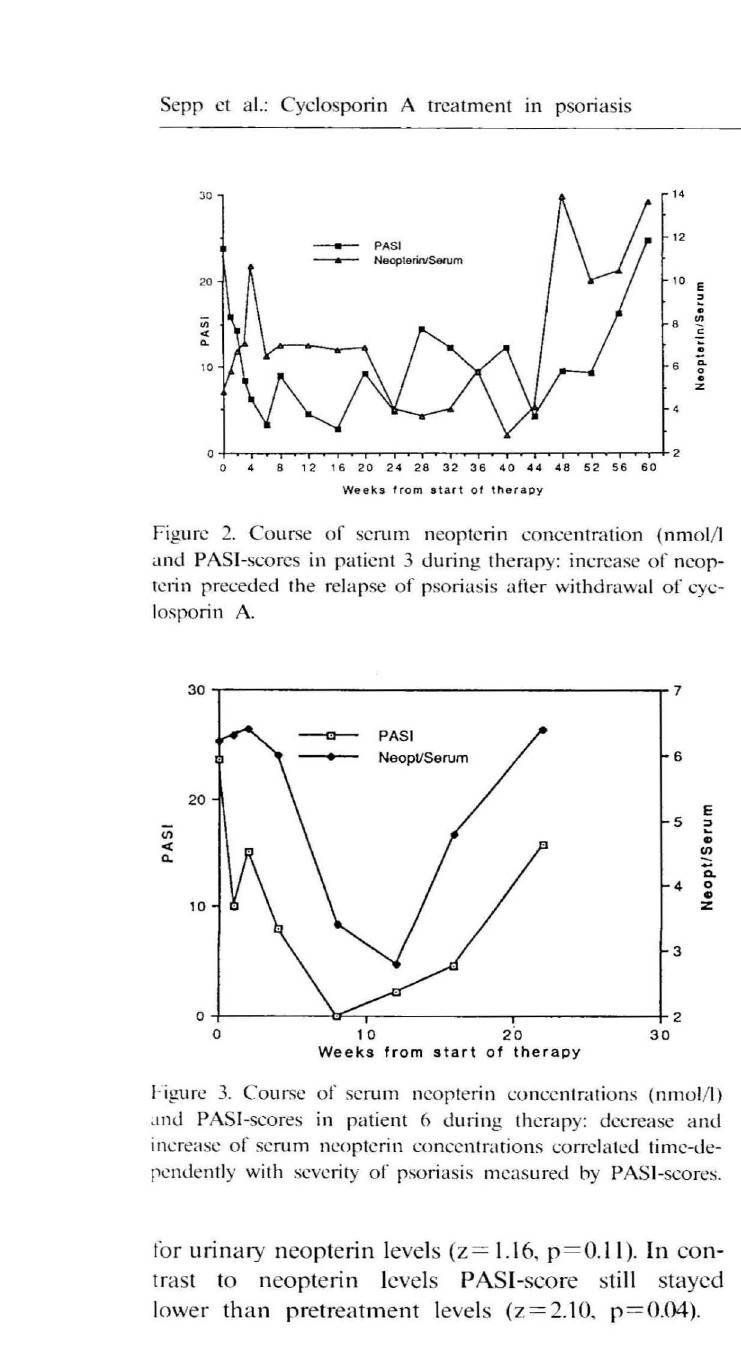
for urinary neopterin levels (z= 1.16, p =O. II). In con trast to neopterin levels PASI-score still stayed lower than pretreatment levels (z=2.1D.